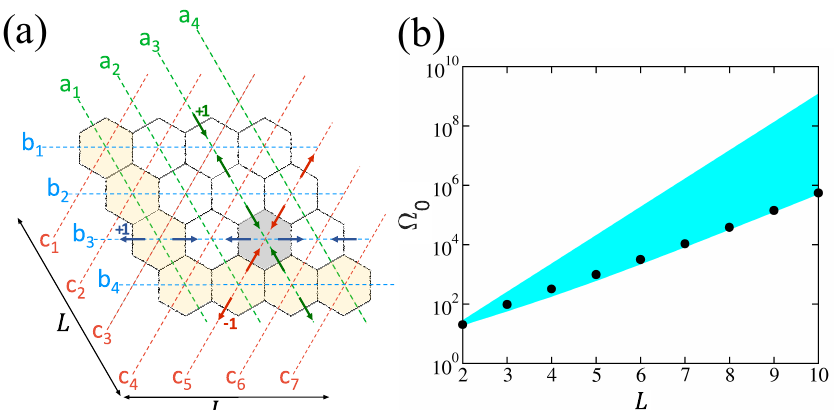
Figure 3: The deformation field of a global soft mode is described according to holographic order and set by the deformations along the boundary, e.g., the yellow hexagons. The holographic order defines 4 L − 1 axes along which deformations al- ternate; a ...a ,b ...b ,c ...c , with L = 4 in this drawing. (b) The number of L L 1 1 1 2 L − 1 compatible rhombic L × L structures, exactly counted up to L = 10 (black dots), falls between the lower and upper bounds (blue region), and is very close to the lower bound, where the leading order is 2 2 L − 1